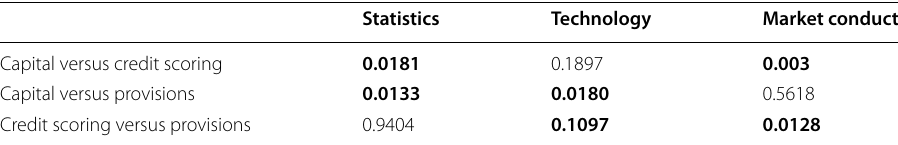
Bold means that differences between model uses are statistically significant at 10% of significance